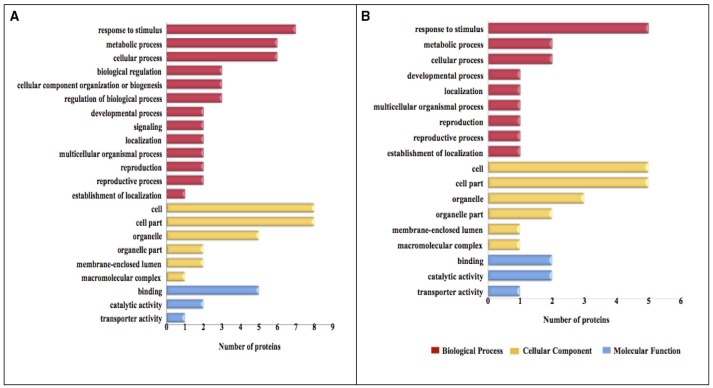
GO categories of the identified proteins in oat seeds with 10 and 16% MC under heat stress. Results are summarized under three main GO categories: biological process, cellular component, and molecular function. (A, 10% MC; B, 16% MC).